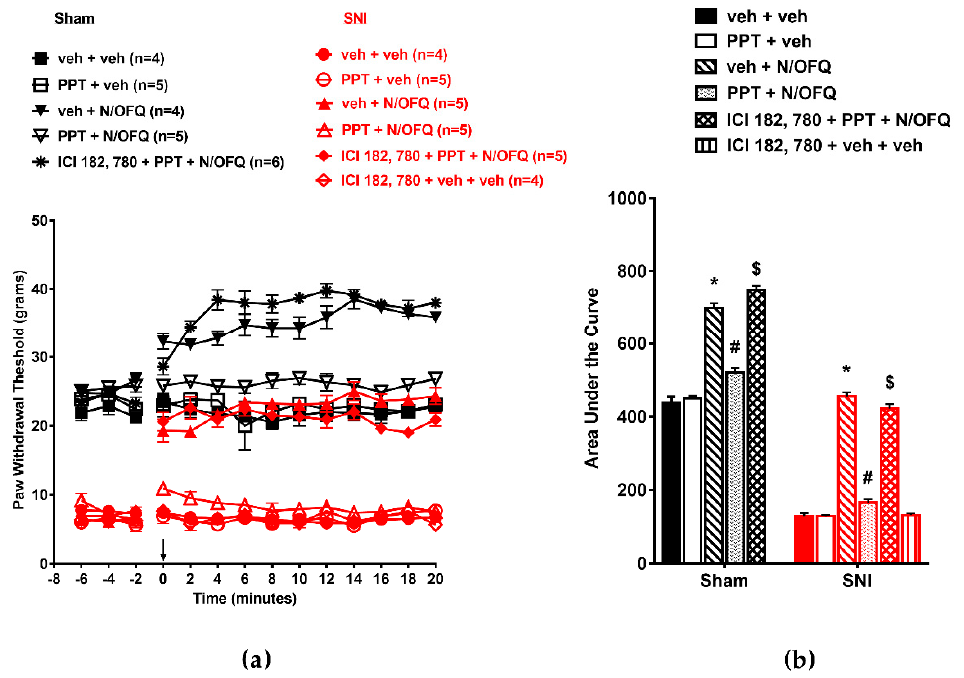
Figure 3. Selective activation of ER α attenuated NOP-mediated antihypersensitivity in OVX rats: ( a ) SNI significantly reduced PWTs compared to the sham group. Intrathecal administration of N/OFQ (10 nM) significantly increased paw withdrawal thresholds, whereas propylpyrazoletriol (PPT) (100 nM), the selective ER α agonist, attenuated the N/OFQ-induced increase in PWTs. Pretreatment with mER antagonist (ICI 182,780) restored an N/OFQ-induced increase in PWTs. ( b ) AUC analysis confirmed these effects, with a significantly reduced AUC in SNI groups, N/OFQ significantly increasing it, and PPT attenuating the effect of N/OFQ in an antagonist-reversible manner. Here, * p < 0.05 compared to veh + veh; # p < 0.05 compared to veh + N/OFQ; $ p < 0.05 compared to PPT + N/OFQ.